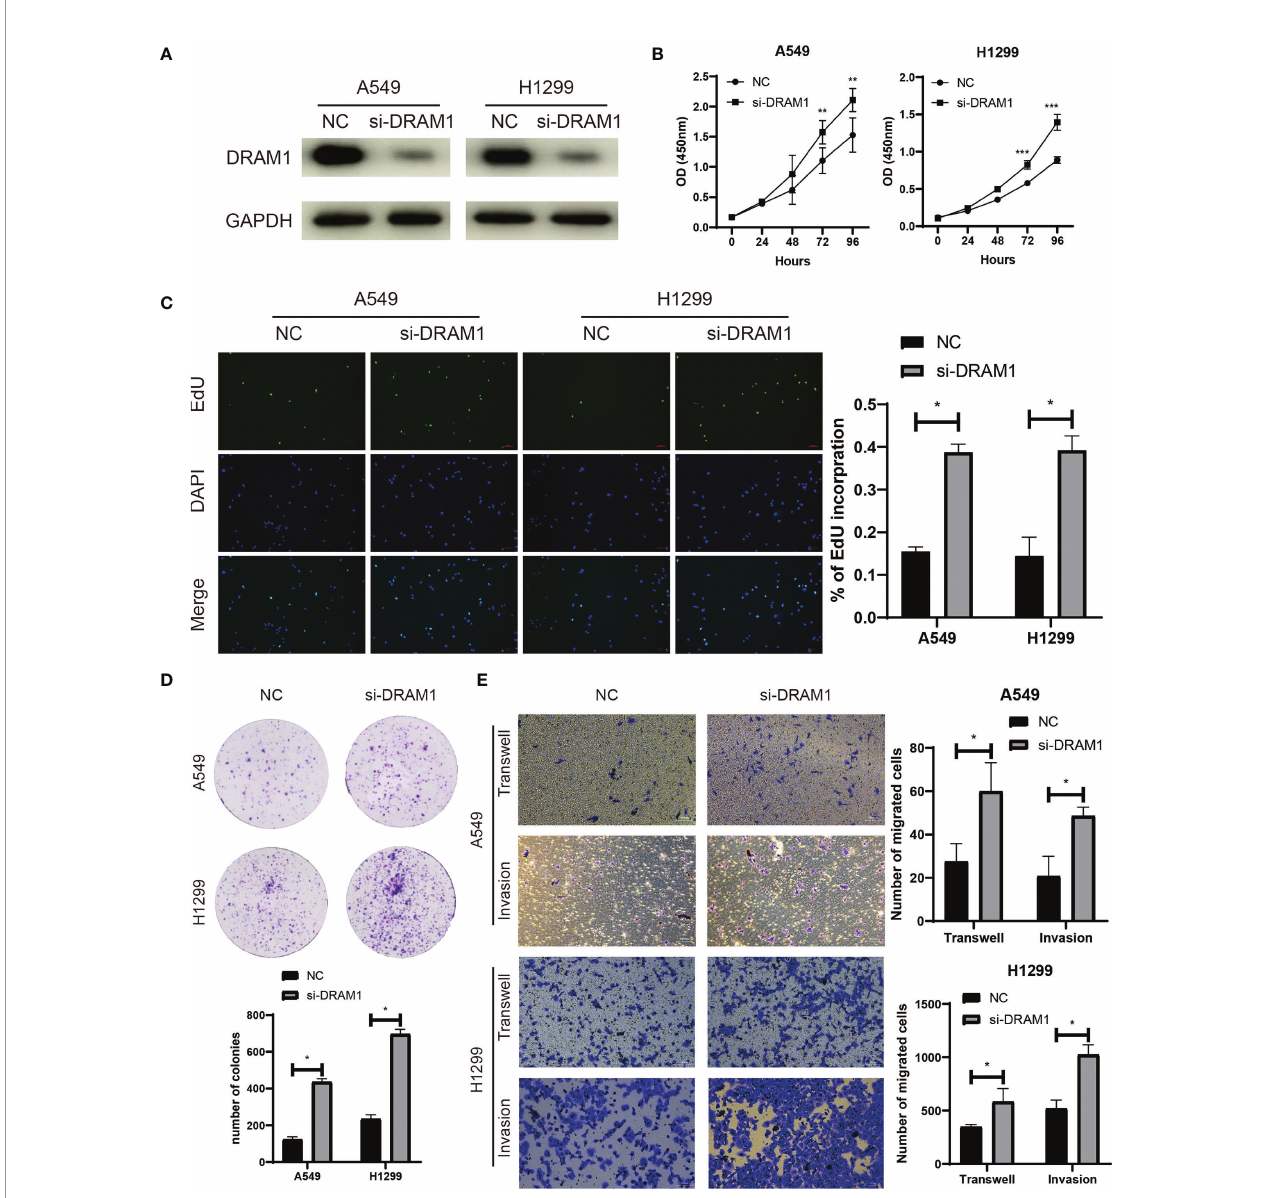
FIGURE 9 | DRAM1 suppressed the proliferation and migration capacity of LUAD cells. The siRNA of DRAM1 signi fi cantly inhibited the expression of DRAM1 in LUAD cells (A) . The results of CCK-8 assays (B) , EdU assays (C) , and colony formation assays (D) revealed that the inhibiton of DRAM1 expression remarkablely promoted the proliferation and the DNA duplication of LUAD cells. The results of Transwell assays and Invasion assays showed that the impairment of DRAM1 expression enhanced the migration and invasion capacity of LUAD cells (E) . *P<0.05, **P<0.01,